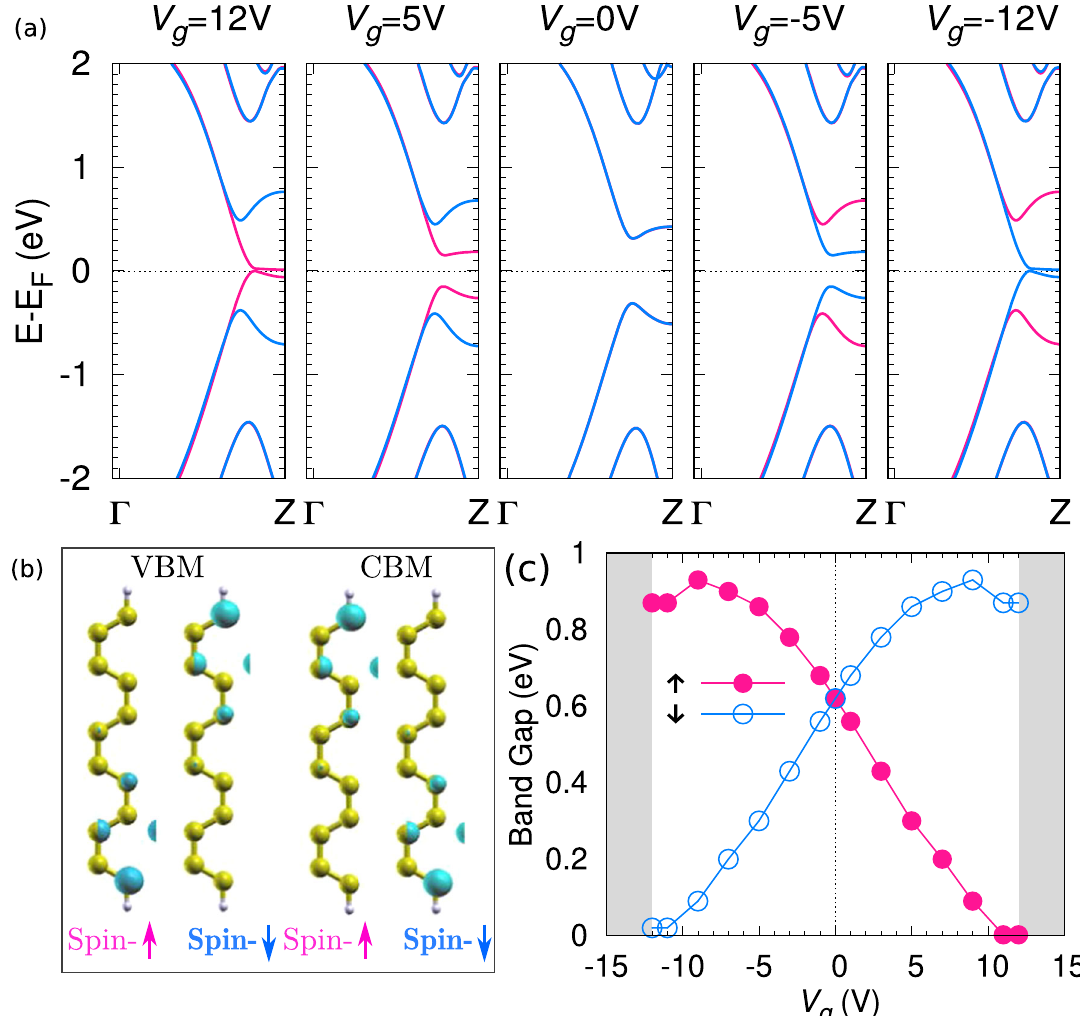
Fig. 2 Electronic properties of 6-ZGNR with and without gate fi leds. a Spin-polarized band structures of 6-ZGNR at different in-plane gate voltages V g . The dark-pink and blue colors denote spin-up ( ↑ ) and spin-down ( ↓ ) states, respectively. b The real-space wave function distributions of the edge states of the 6-ZGNR. c The gate voltage dependence of the band gap for the spin-up ( ↑ ) and spin-down ( ↓ ) states. The gray shaded areas denote that half-metallicity can be